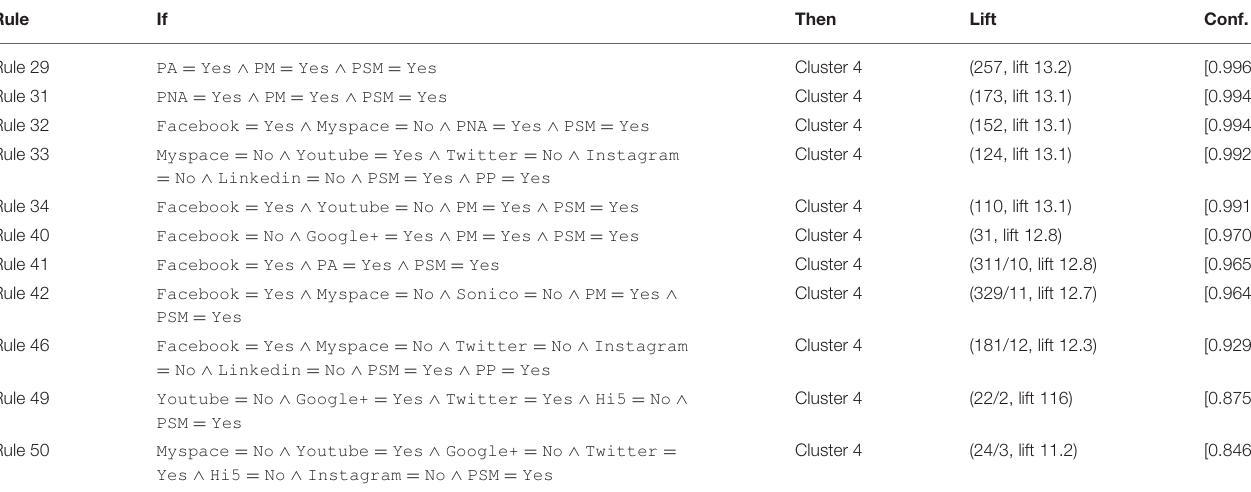
Yes ” for classifying individuals in the Online Activist =